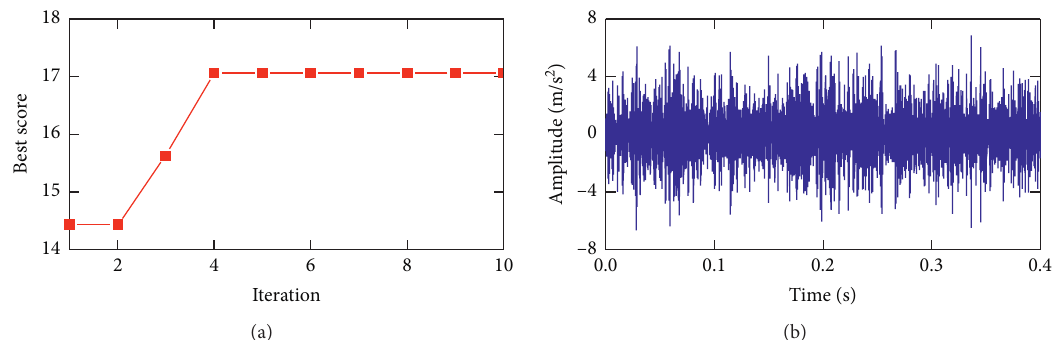
Figure 27: The experimental signal denoising results: (a) fitness convergence curve for PPCA optimization; (b) time-domain diagram after noise reduction by APPCA.